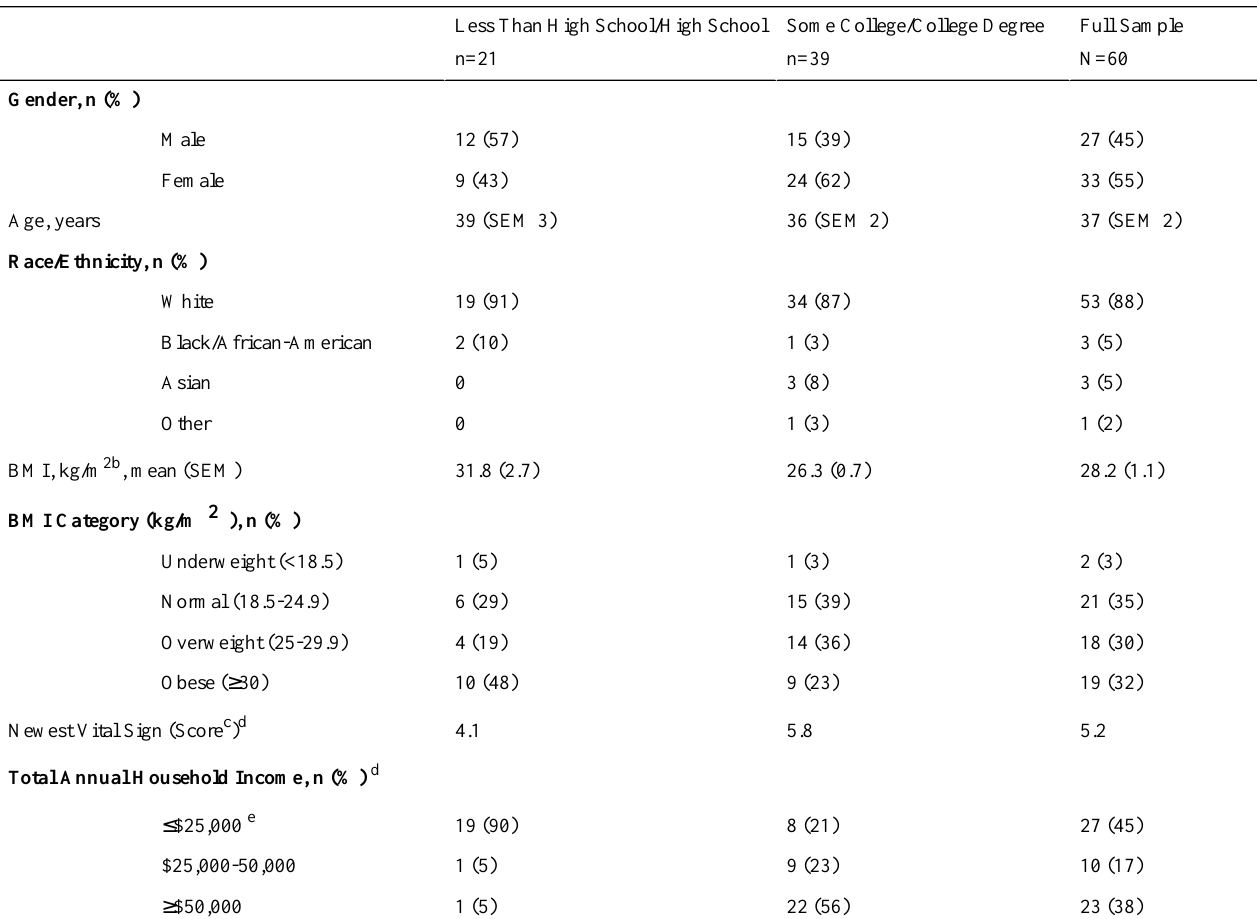
Table 1. Participant demographic characteristics.